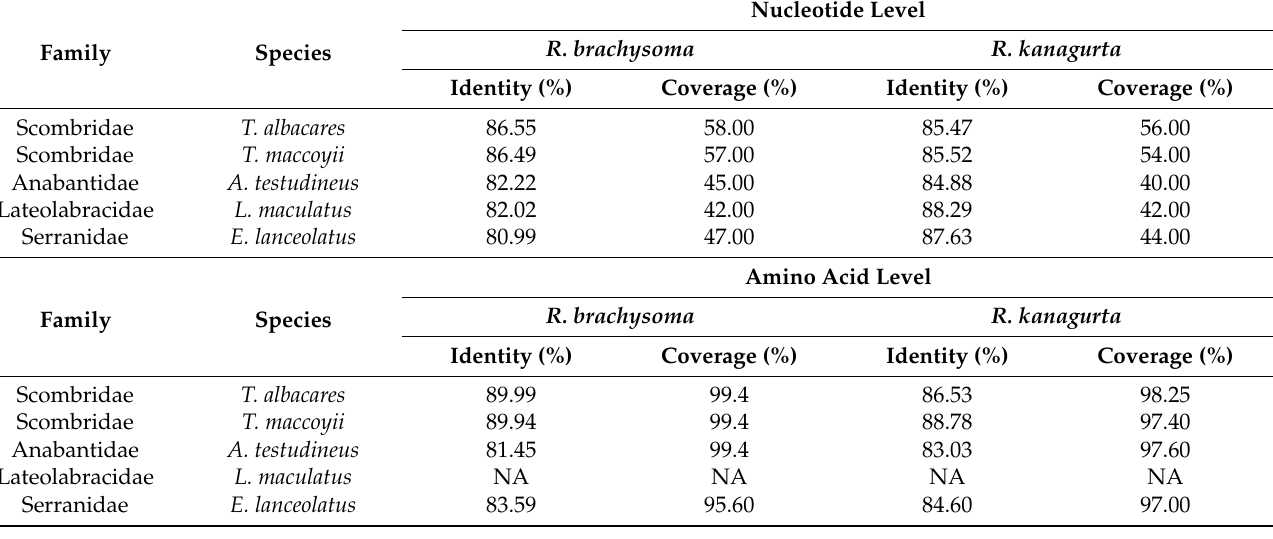
Table 3. The average nucleotide and amino acid similarity between R. brachysoma and R. kanagurta and other